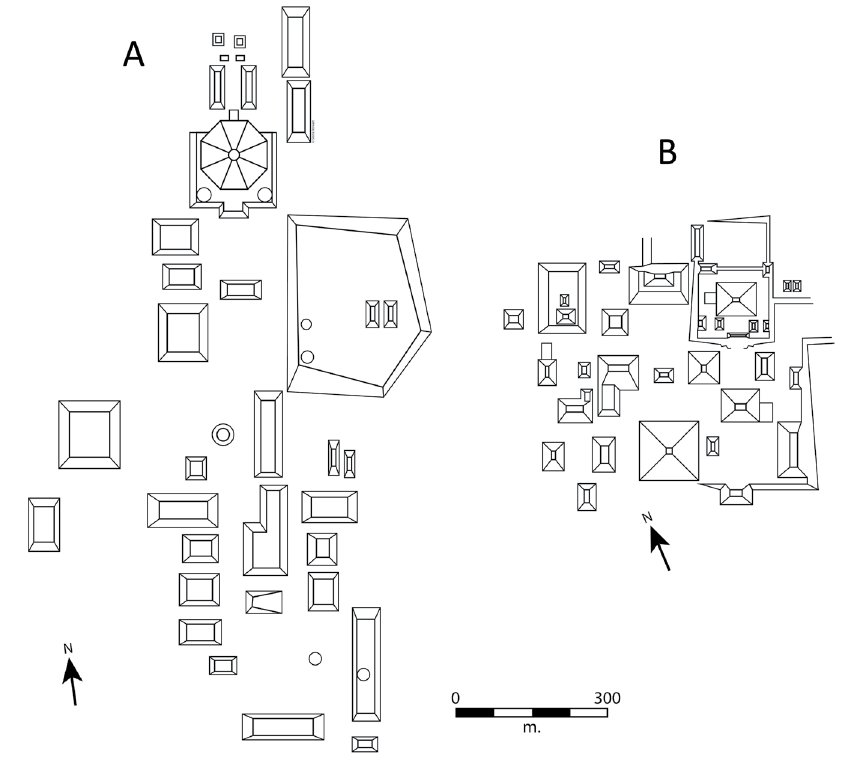
Figure 2. Preclassic urban centers. Plans by Sierra Stewart A: La Venta, redrawn from Diehl (2004:61). B: Izapa; redrawn from Coggins